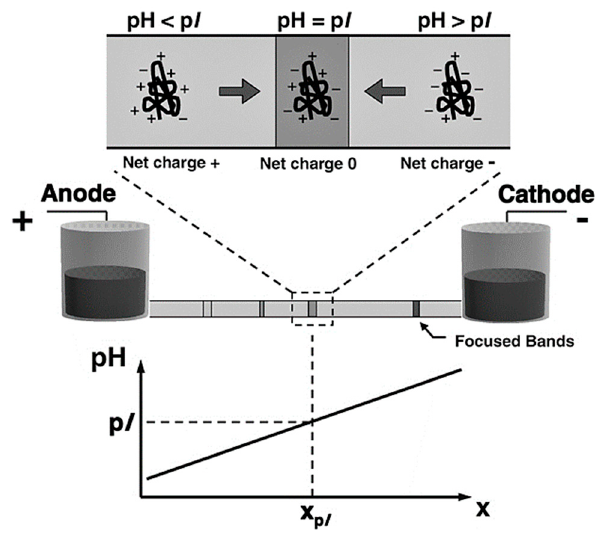
Figure 19. IEF concept schematic. Amphoteric molecules are driven along the pH gradient towards their PI. (Reprinted from Sommer and Hatch, 2009 [138], with permission from Wiley-VCH Verlag GmbH & Co. KGaA, Weinheim).